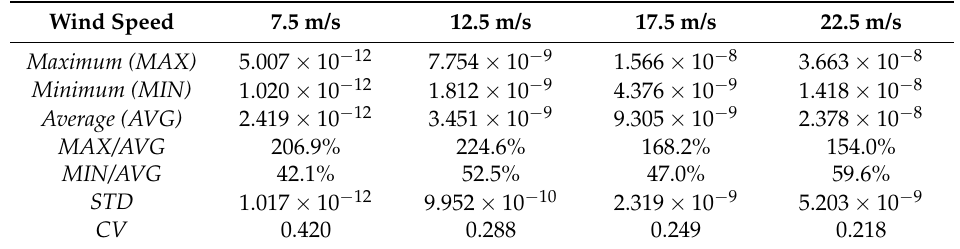
Figure 7. ( a ) Fatigue damage and characteristic fatigue damage (CFD), both dimensionless, of the 60 short-term simulations when the wind speed ( U w ) is 7.5 m/s. The uncertainty among the 60 simulations was clear despite simulating under identical weather conditions; ( b ) Fatigue damage distribution over a specific wind speed. Table 1. Extreme and average values, relative standard deviation (CV), and the deviation of the fatigue damage for the wind-load-alone